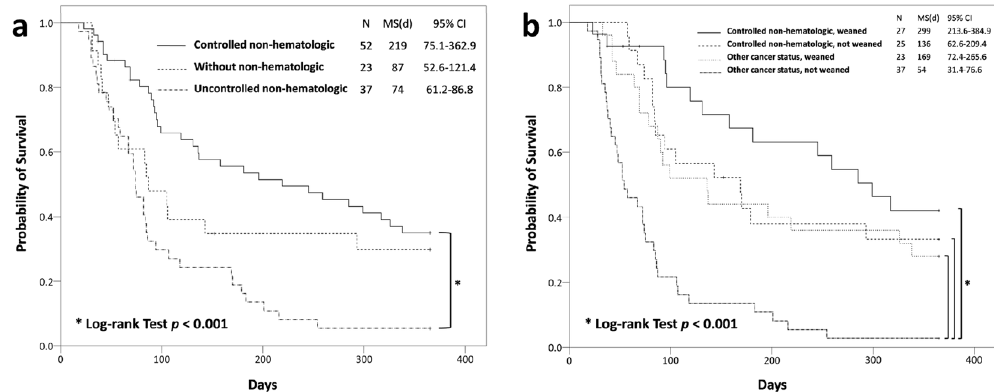
Figure 1. Kaplan-Meier curves for survival in cancer patients treated with prolonged mechanical ventilation, with stratification by cancer diagnosis and status ( a ), and weaning outcome and cancer status ( b ). CI, confidence interval; MS, median survival.